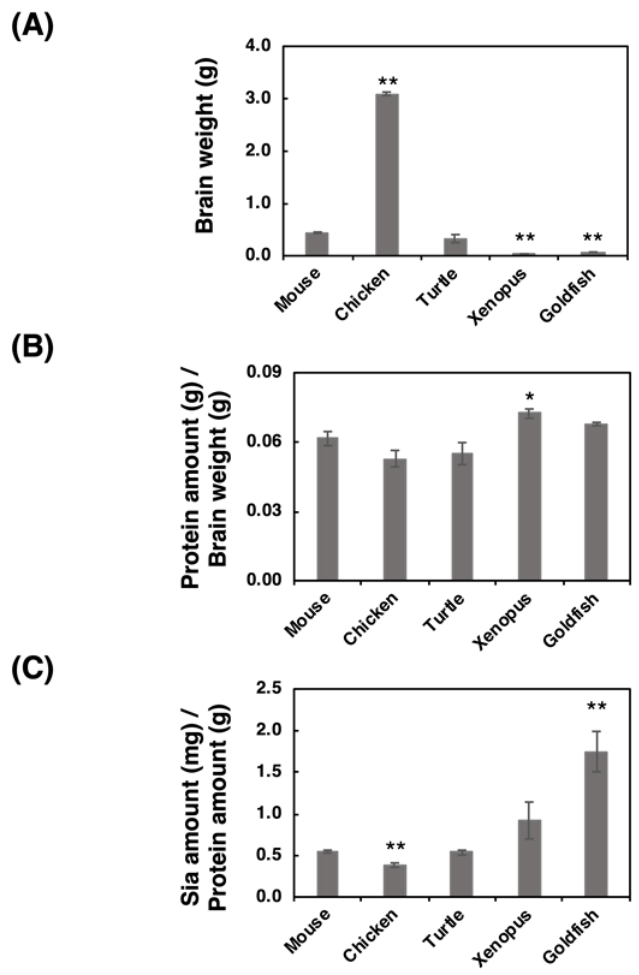
Figure 1. Comparison of brain weight, protein concentration, and Sia concentration for the five di ff erent vertebrate brains. Brains from five di ff erent vertebrates (mouse, chicken, turtle, xenopus, goldfish, ( n = 3)) were used. ( A ) Comparison of the brain weights of the five vertebrate brains. ( B ) Protein amount (g) per brain weight (g). Brains were homogenized using lysis bu ff er, and a bicinchoninic acid (BCA) assay was performed to determine the protein concentration. ( C ) Sia amount (mg) per protein amount (g). Brain homogenate was treated with a strong acid to achieve hydrolysis of sialylglycoconjugates. All Sia residues were completely released and labeled with 1,2-dimethylenedioxybenzen (DMB). Sia–DMB was separated using a Wako Handy octadecylsilyl (ODS) column (250 mm × 4.6 mm, Wako). The absolute amount of Sia was calculated based on the authentic Neu5Ac. * indicates p < 0.05. ** indicates p < 0.01.